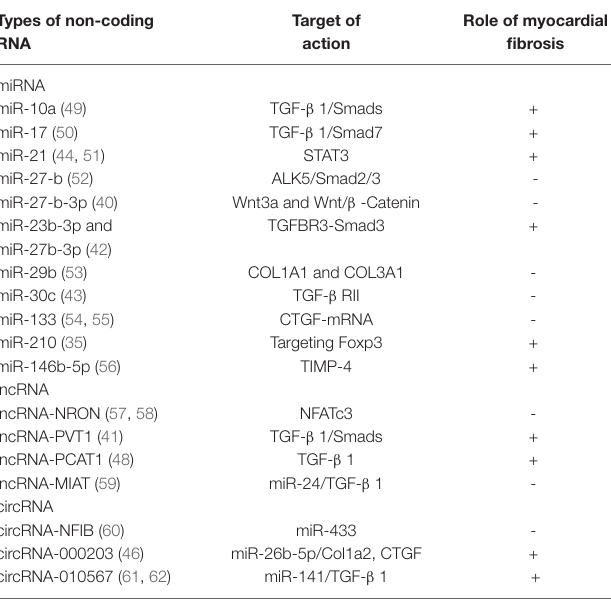
TABLE 1 | Studies of the relationship between non-coding RNA and myocardial